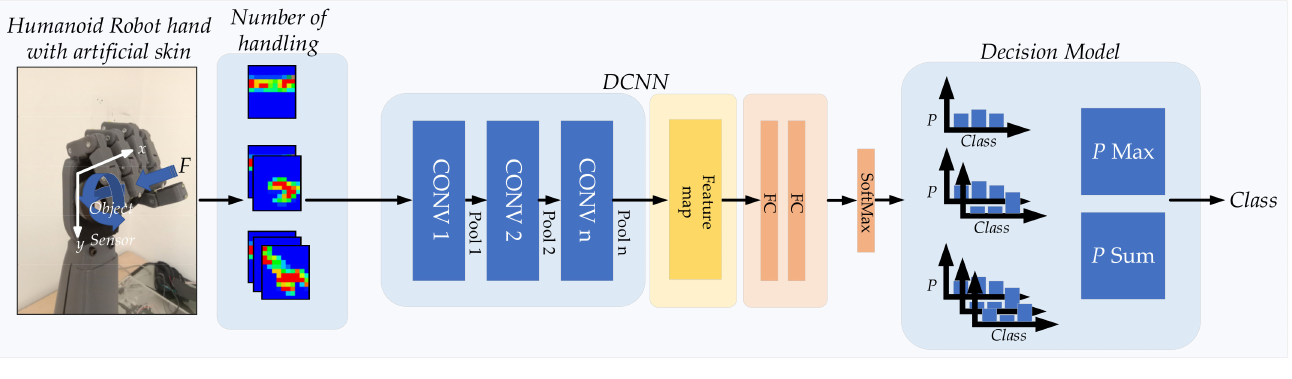
Figure 25. Object recognition from object